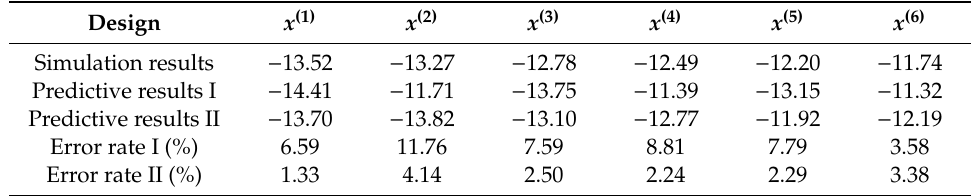
Table 5. Comparison of Fitness Values F1 of Selected Pareto-Optimal Designs Obtained by Surrogate Model and HFSS.